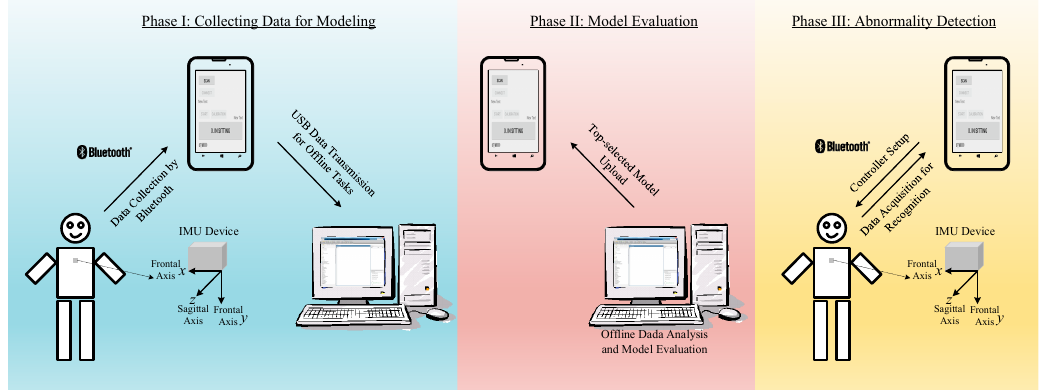
Figure 4. General configuration of the facilities for realistic experiments.